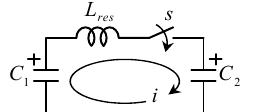
Figure 22. A basic resonant switched-capacitor circuit. The charge interchange is different than the pure SC case. The main differences are that (i) the current tends to be sinusoidal, and (ii) we can stop the current before it finds an equilibrium (preferably during a zero crossing), meaning the final voltage of capacitors would be different v 1 f ≠ v 2 f . In other words, the inductor is chosen in a way that the current has a resonant behavior. This requires a very small inductor, much smaller than the energy storage inductors. If we let the circuit reach the equilibrium, parasitic resistances would damp the current, and it will become zero when capacitors are charged to the same voltage, which would lead to the same result of pure switched-capacitor circuits. However, the most common choice is to allow only a half-sine wave in the current, which leads to a current as shown in Figure 19, which is more detailed in Figure 23.